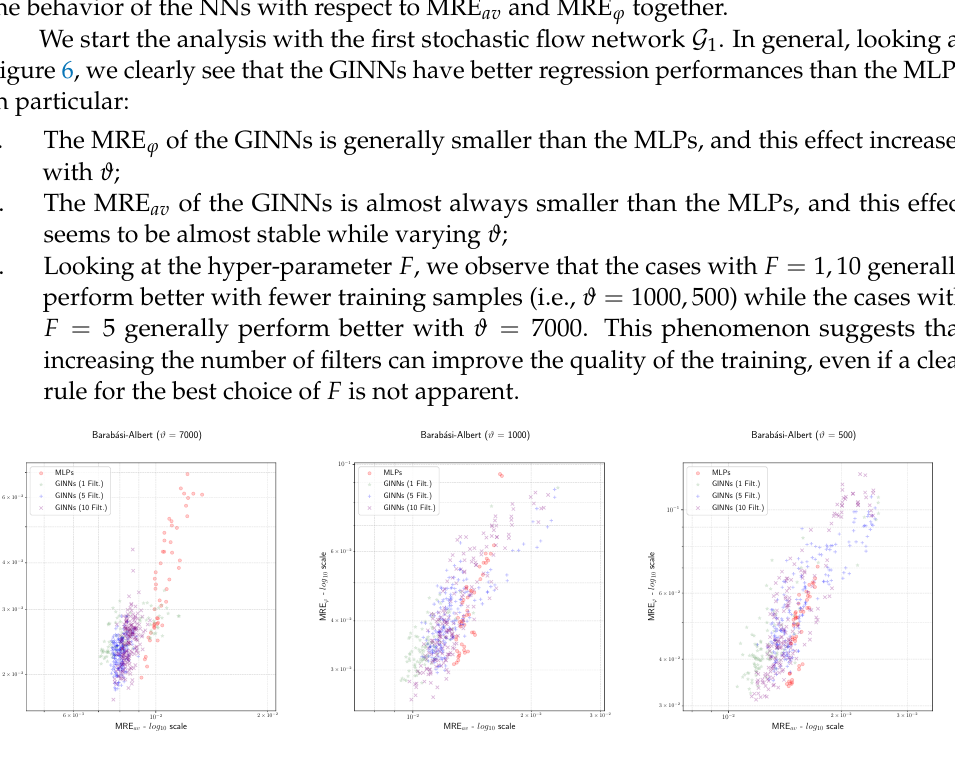
Figure 6. Network . Scatter plots in the ( MRE av ,MRE ϕ ) plane. Left to right: NNs trained with G 1 ϑ = 7000,1000,500 samples. Red circles: MLPs; green stars, blue crosses and purple “x”: GINNs with F = 1,5,10,